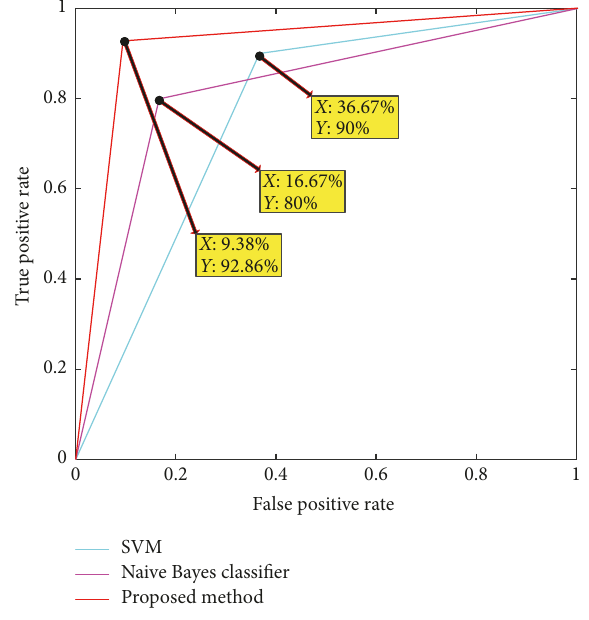
Figure 10: ROC curves for different classifying methods. Table 4: Classification accuracy with different scale factors.